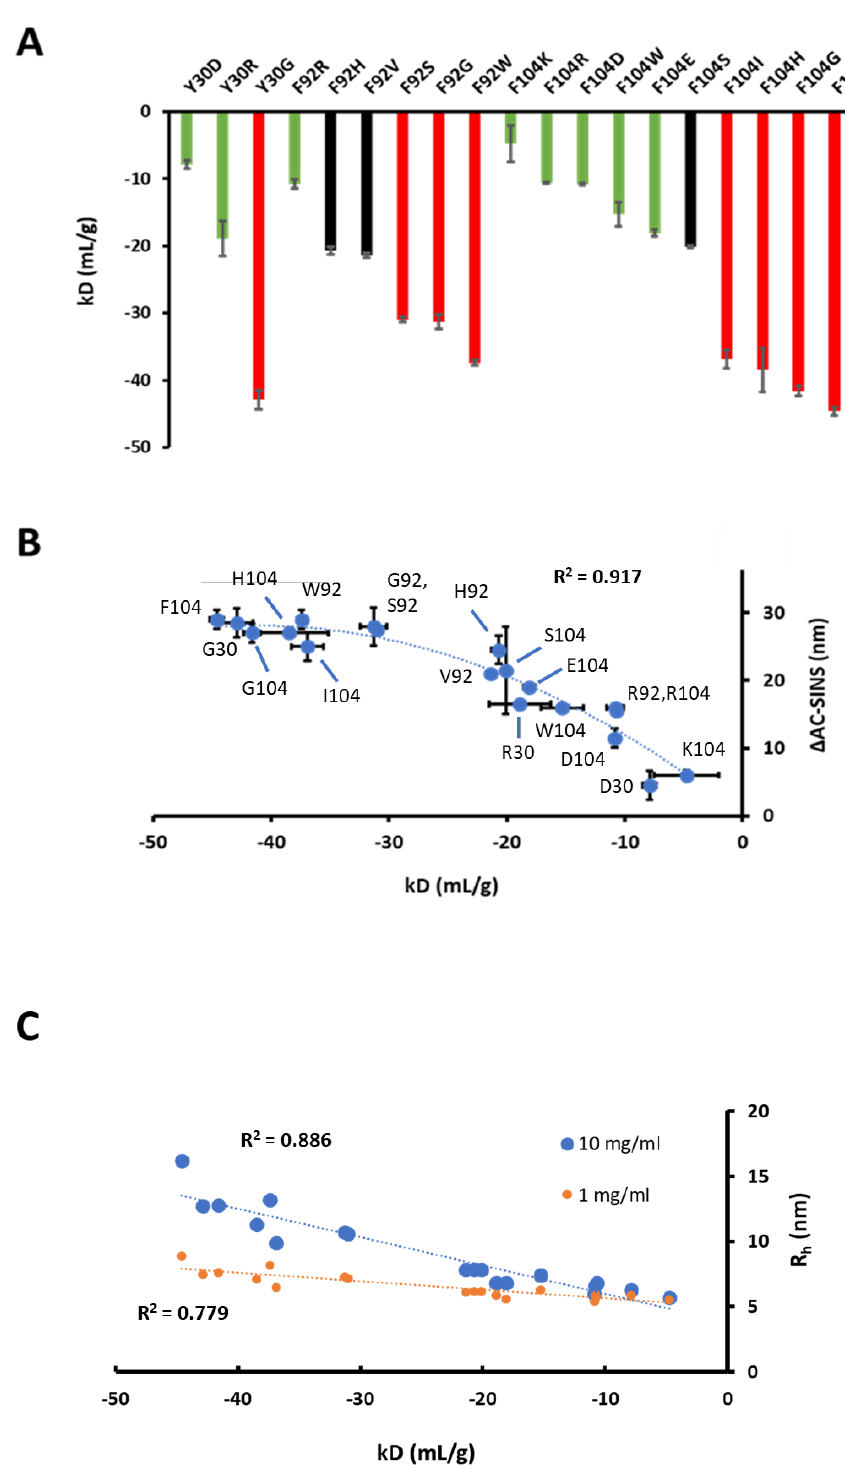
Figure 7. ( A ) kD (mL/g) obtained by DLS (1–10 mg/mL in PBS) shown as bar plots for all variants engineered at HC-104, LC-Y30, and LC-F92. Obtained kD values less than − 30 mL/g are shaded red bars, and those higher than − 20 mL/g are shaded green. Values between − 20 and − 30 mL/g are shaded black. Error bars are shown. ( B ) kD values obtained for all 19 interface mutants are plotted against corresponding ∆ AC-SINS values (blue circles with error bars for each method and the R 2 of the parabolic fit). Each data point is labeled by variant. ( C ) kD values obtained for all 19 interface mutants are plotted against corresponding R h values (nm) obtained at both 1 mg/mL (orange circles) and 10 mg/mL (blue circles) along with R 2 of the linear